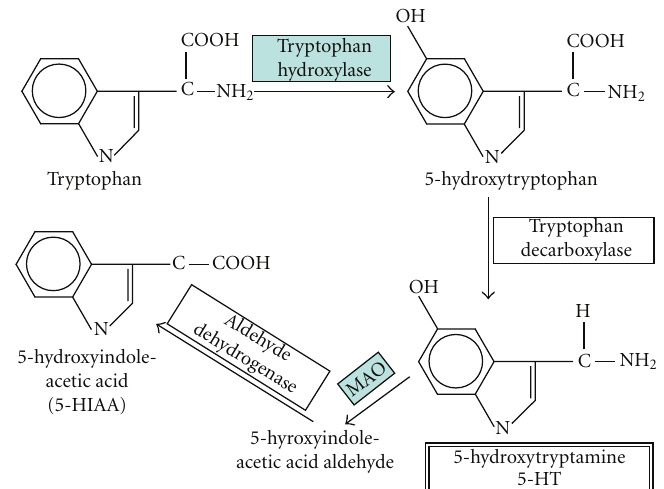
Figure 1: Contribution of tryptophan hydroxylase and MAO in serotonin metabolism. Tryptophan hydroxylase catalyzes the monooxy- genation of tryptophan to 5-hydroxytryptophan, which is subsequently decarboxylated to form serotonin (5-hydroxytryptamine; 5-HT). Monoamine oxidase (MAO) catalyzes the oxidative deamination of 5-HT to the corresponding aldehyde. This is followed by oxidation by aldehyde dehydrogenase to 5-HIAA, the indole acetic acid